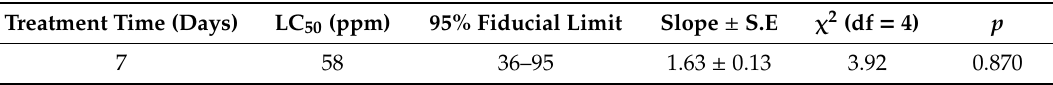
Median lethal concentration (LC 50 ) values of Beauveria brongniartii Fe 0 NPs against Spodoptera litura estimated by probit regression.